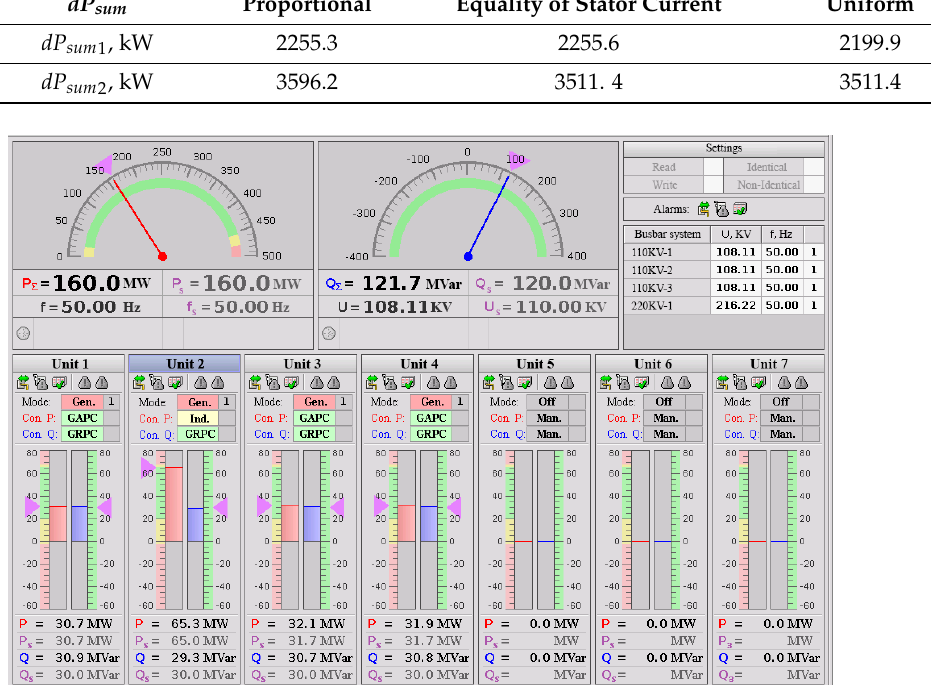
Figure 8. The main window of the digital AGC system: unit 2 has constraints on apparent power.